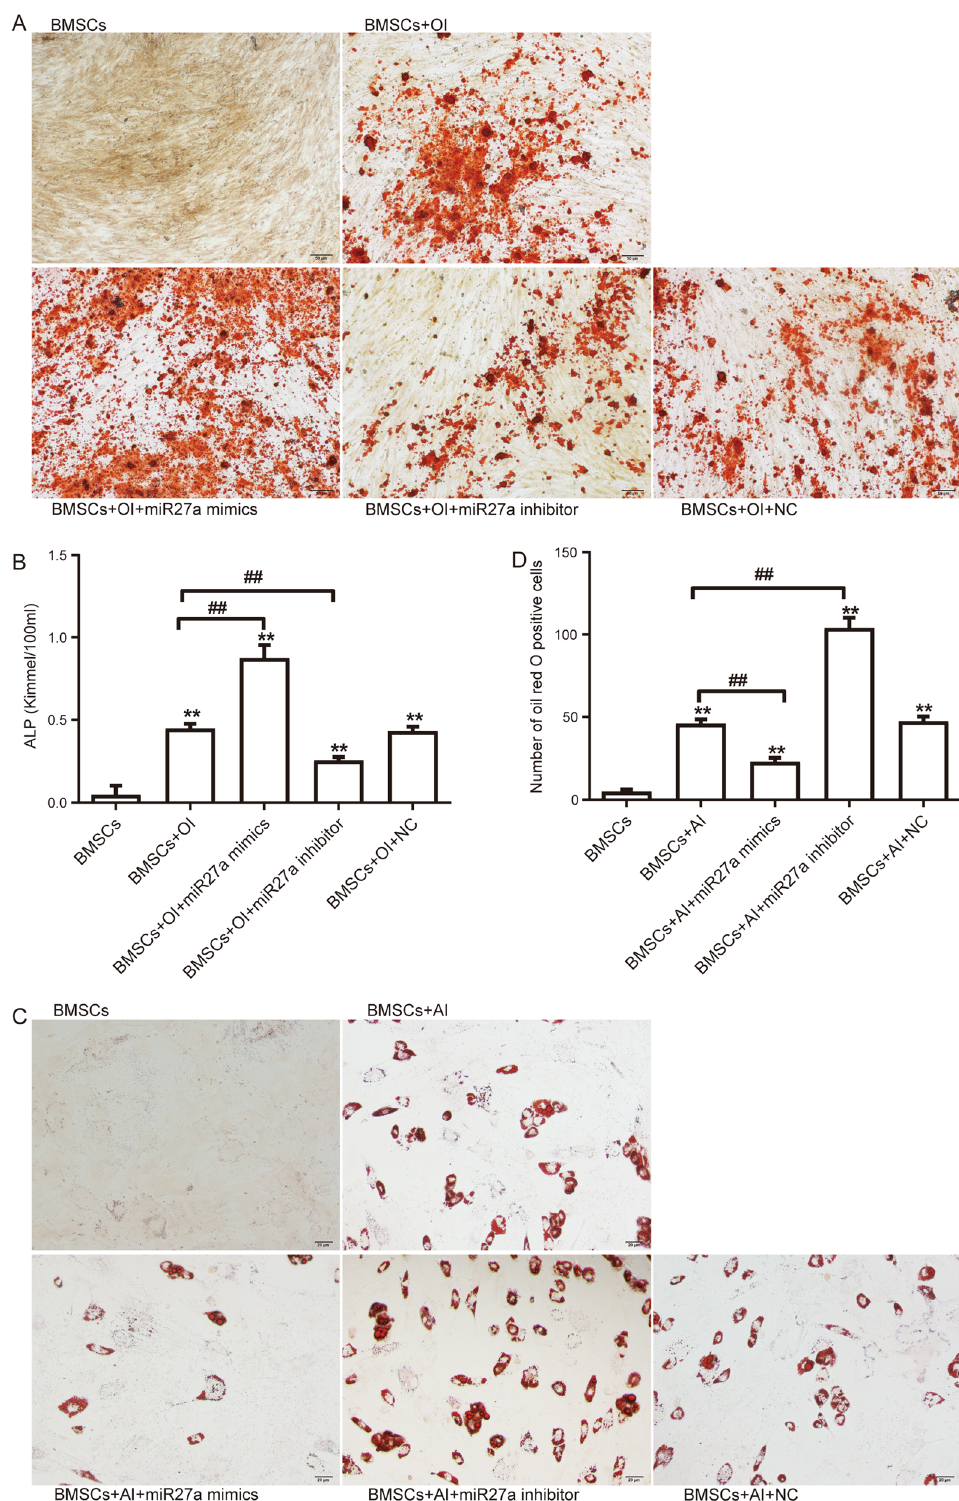
Figure 3. Osteogenic differentiation and adipogenic differentiation of BMSCs effected by miR-27a. ( A ) Alizarin red staining of BMSCs after osteogenic induction (OI). Scale bar, 50 μm. ( B ) The ALP activity of BMSCs after osteogenic induction (OI). ** P < 0.01 vs BMSCs, ## P < 0.01 vs BMSCs after OI. ( C ) The oil red O staining of BMSCs after adipogenic induction (AI). Scale bar, 20 μm. ( D ) Number of oil red O-positive cells in different groups. ** P < 0.01 vs BMSCs, ## P < 0.01 vs BMSCs after